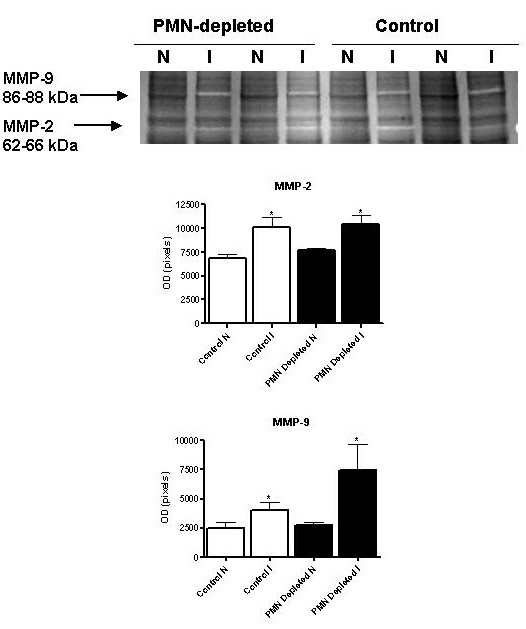
MMP activity is increased in focal cerebral ischemia. (A) Representative zymogram showing changes in MMP activity in the ischemic (I) and non-ischemic (N) hemispheres. (B) Densitometric analysis of lytic bands indicates increases in MMP-2 and MMP-9 activity in ischemic hemispheres from control and PMN-depleted animals. Anti-PMN antibody treatment has no affect on MMP activity. (*p < 0.05 vs contralateral hemisphere, control n = 6, PMN n = 4).